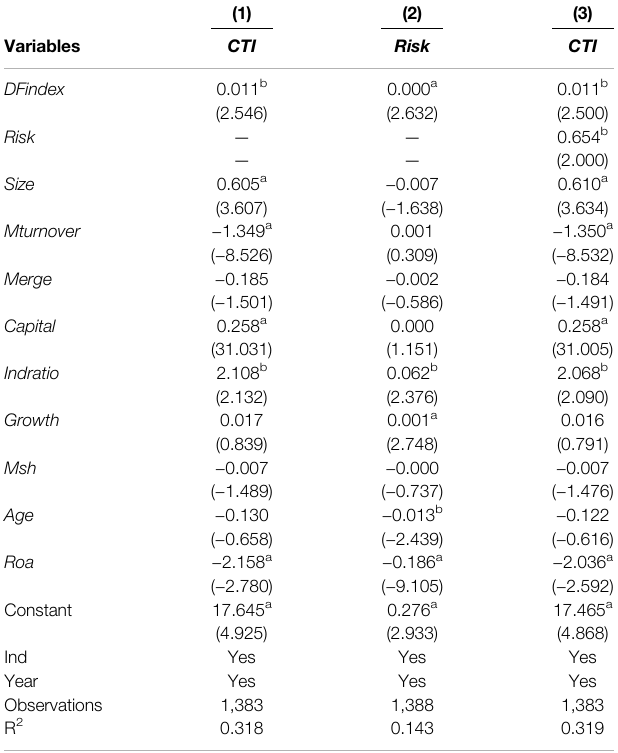
TABLE 5 | Estimations of the risk-taking mechanism: robustness